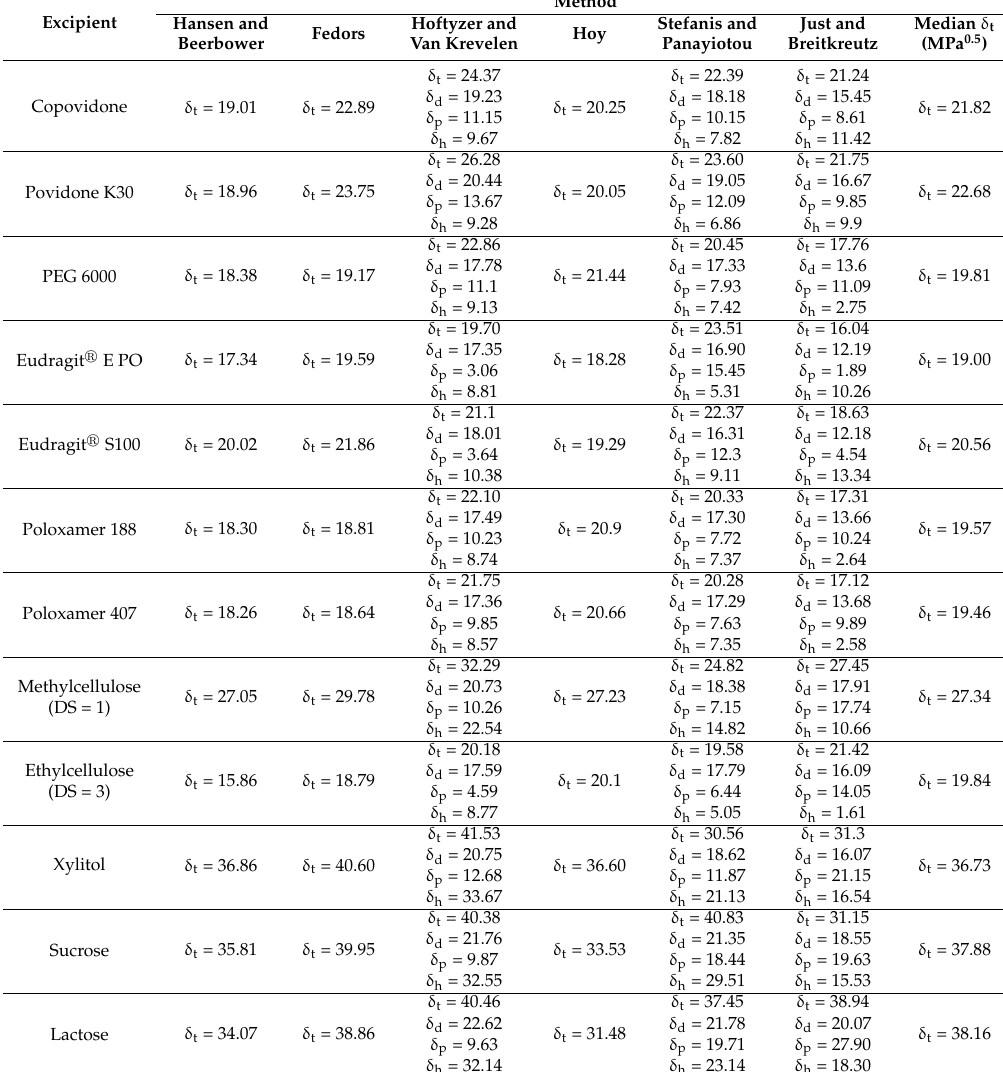
Table 2. Values of solubility parameters for polymers and excipients by using six different group contribution